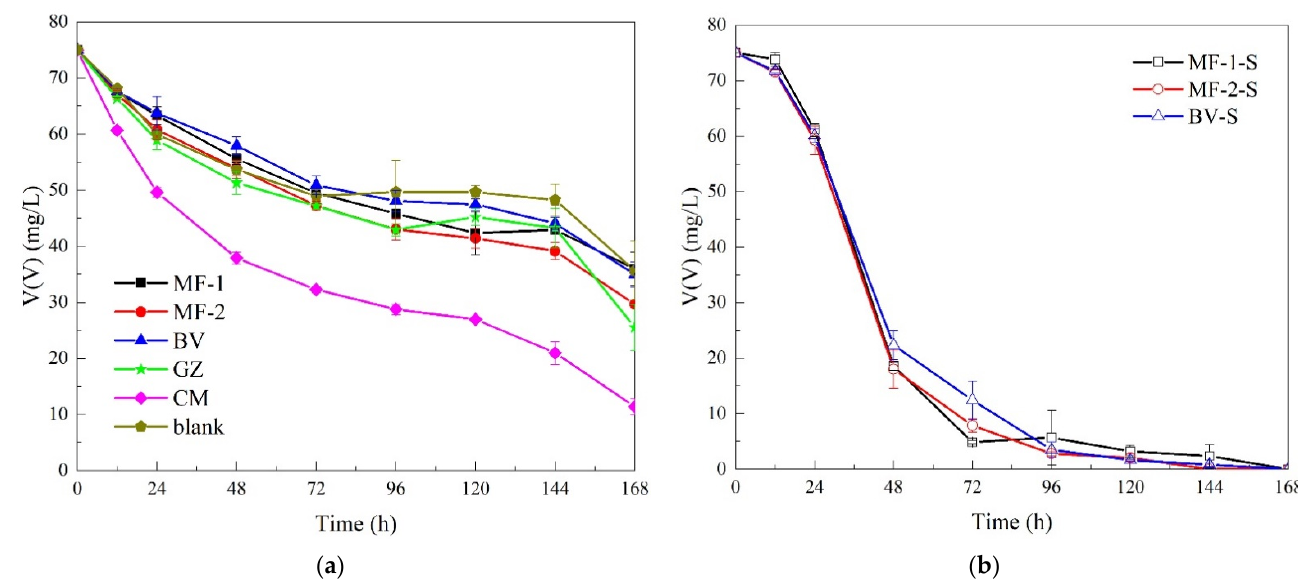
Figure 1. ( a ) V(V) removal by straw and various fillers (Group MF-1, MF-2, BV, GZ, CM and blank);